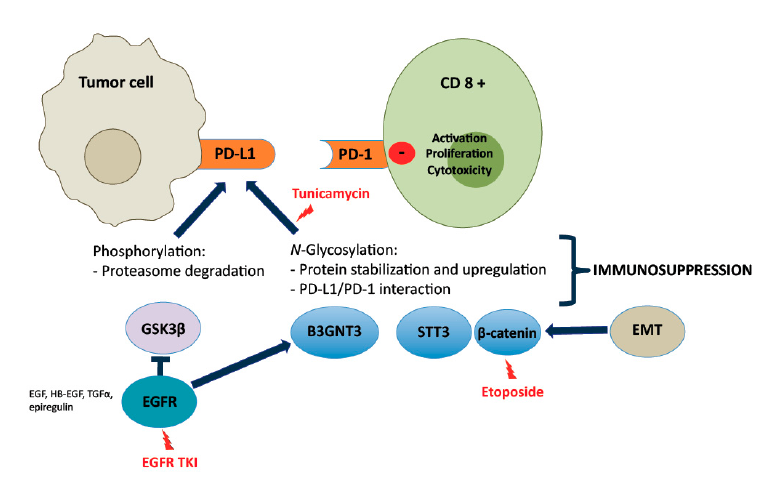
Figure 1. PD-L1 glycosylation and selected proteins involved in the mechanism of glycosylation and phosphorylation of PD-L1. Glycogen synthase kinase 3 β (GSK3 β ), phosphorylates PD-L1, leading to its ubiquitination. EGFR, activated by its ligand EGF, epiregulin, TGF α , and heparin-binding EGF, induces PD-L1 expression by inhibiting GSK3 β . EGFR tyrosine kinase inhibitors (TKIs) can prevent this mechanism. β -1,3-N-acetylglucosaminyl transferase (B3GNT3) is involved in PD-L1 glycosylation, and it is upregulated by EGFR. N-glycosyltransferase STT3 positively regulates PD-L1 glycosylation; Epithelial–mesenchymal transition (EMT) induces N-glycosyltransferase STT3 through β -catenin. N-linked glycosylation can be inhibited by tunicamycin. Etoposide, reduces nuclear β -catenin and inhibits the EMT- β -catenin-STT3-PD-L1 signaling.